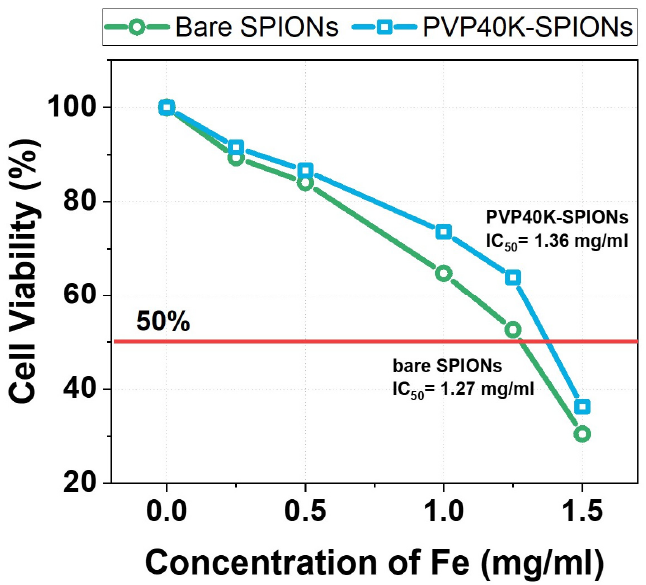
Figure 6. Cytotoxicity of bare SPIONs and PVP40K-SPIONs on T-Cells. Figure 6 depicts a blue line that indicates the half maximal inhibitory concentration (IC50), or the concentration at which 50% cell viability is inhibited. The IC50 of PVP40K- SPIONs was found to be 1.44 mg/mL, while that of bare SPIONs was 1.38 mg/mL. At con- centrations below 1.0 mg/mL, PVP40K-SPIONs did not display any cytotoxic e ff ects on T- cells, and the cells remained over 75% viable compared to the control. The reduced cyto- toxicity of PVP40K-SPIONs can be a tt ributed to the improved biocompatibility imparted by the PVP40K coating. Our fi ndings suggest that surface modi fi cation of SPIONs plays a critical role in determining their cytotoxicity. Based on the in vitro cytotoxicity results, it can be inferred that PVP40K-SPIONs can be used as a contrast agent for biomedical ap- plications in MRI at concentrations below 1.0 mg/mL, with the concentration being deter- mined as conservatively as possible. 3.6. Relaxometry Measurements of SPIONs The use of the bare SPIONs and PVP40K-SPIONs as contrast agents in MRI was stud- ied using 1.5 T MRI scanner. As shown in Figure 7, the longitudinal and transverse relax- ivities (r 1 and r 2 ) of the samples were measured from the slope of the linear fi t of 1/T 1 and 1/T 2 , respectively, against Fe concentration. Values for r 1 , r 2 , and (r 2 /r 1 ) ratio have been measured to determine the e ffi ciency of the sample as a MRI contrast agent [39,40].